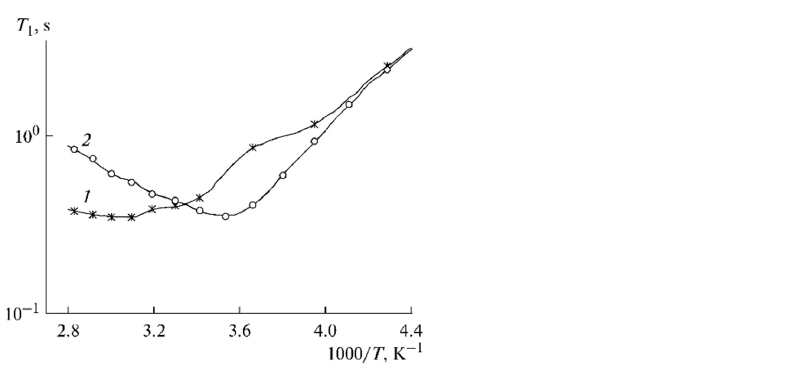
Figure 15. Temperature dependences of the 7 Li spin-lattice relaxation time T 1 for PGE nos. ( 1 ) 2 and ( 2 ) 9 [53]. The temperature dependences of the correlation times are shown in Figure 16.